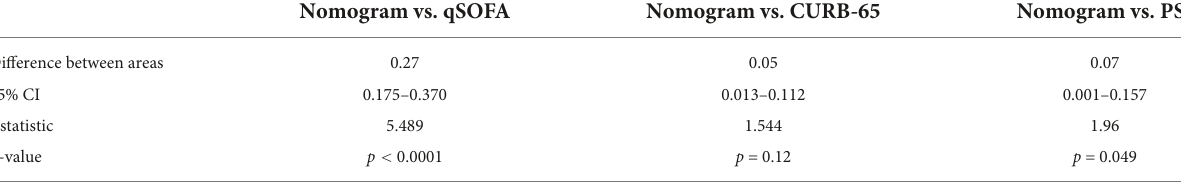
TABLE 7 Comparison of ROC for mortality in validation cohort.